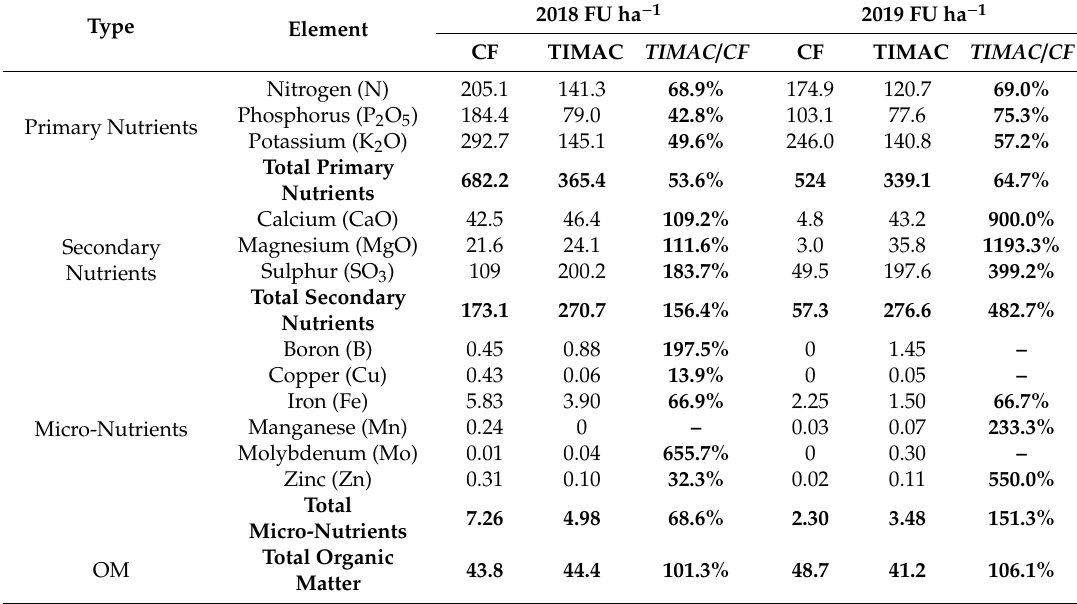
Table 3. Fertilisation units (FU) applied per treatment and hectare in 2018 and 2019